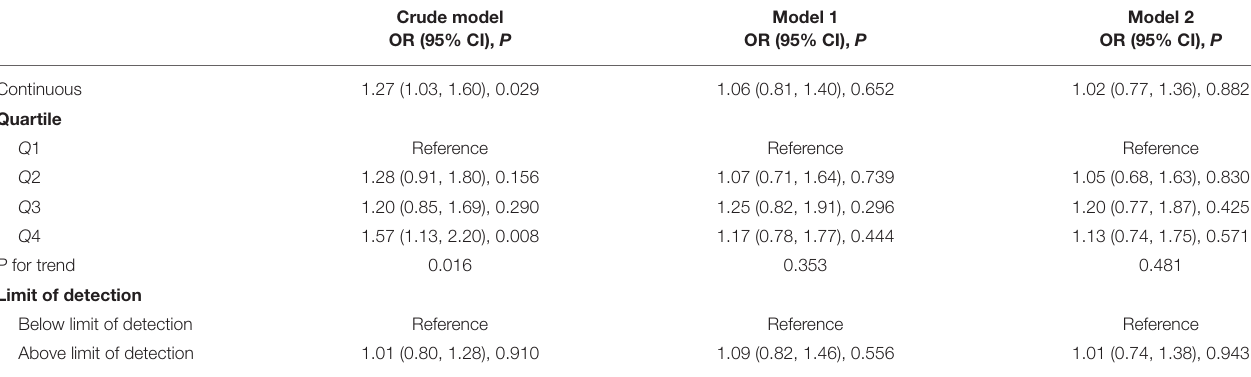
Crude model: non-adjusted model. Model 1: adjust for age, race, and BMI. Model 2: adjust for age, race, ratio of family income to poverty, education level, marital status, BMI, alcohol intake, smoking, physical activity, cardiovascular disease, diabetes, hypertension, and high cholesterol. BMI, Body mass index; OR, Odds ratio; CI, Confidence interval; NHANES, National Health and Nutrition Examination Survey.